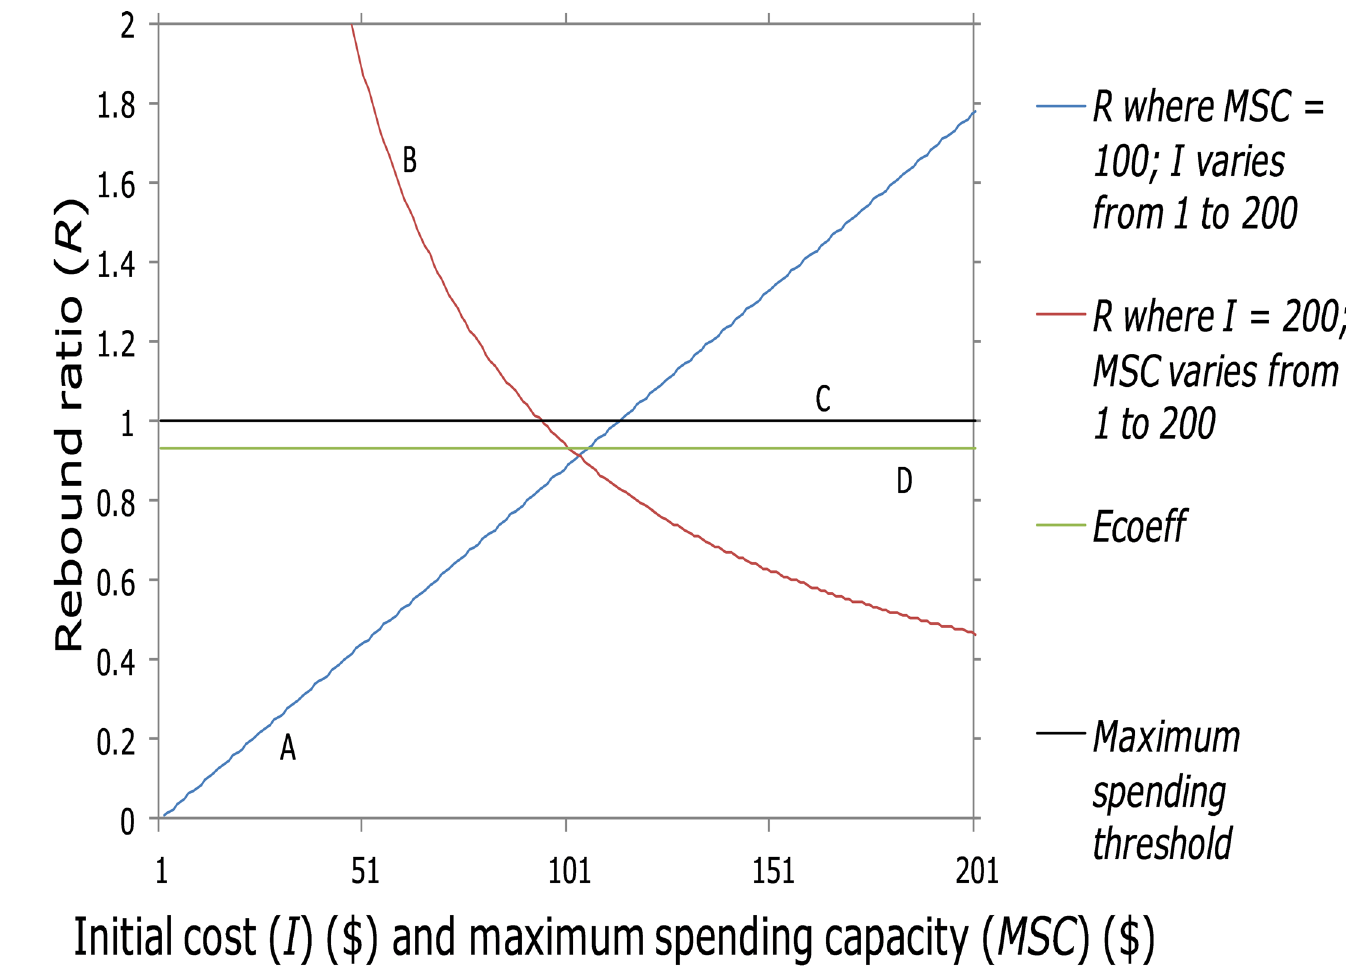
Fig 1. Rebound ratio curves. To illustrate, for curve A the initial cost ( I ) of the energy service varies between $1 and $200; for curve B a consumer ’ s maximum spending capacity ( MSC ) varies between $1 and $200. Curve C is the de-coupling threshold between the cost of the service as attenuated by the energy services savings quantity, and the consumer ’ s capacity to pay. The energy service efficiency is 0.08 based on [17], and the rebound is 0.22, based on data in [14], and E coeff is 0.9376 (curve